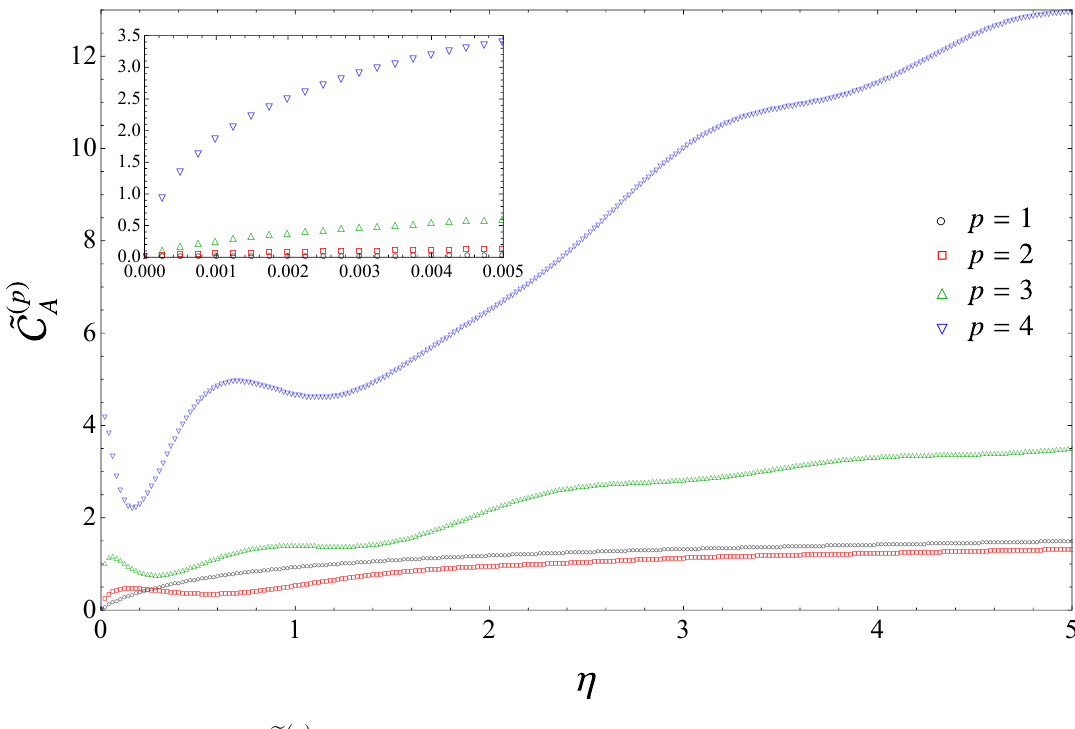
Figure 15. Cumulants e C ( p ) (1) = S A . The inset zooms in on η ∼ 0 + and shows that e C ( p ) e C A